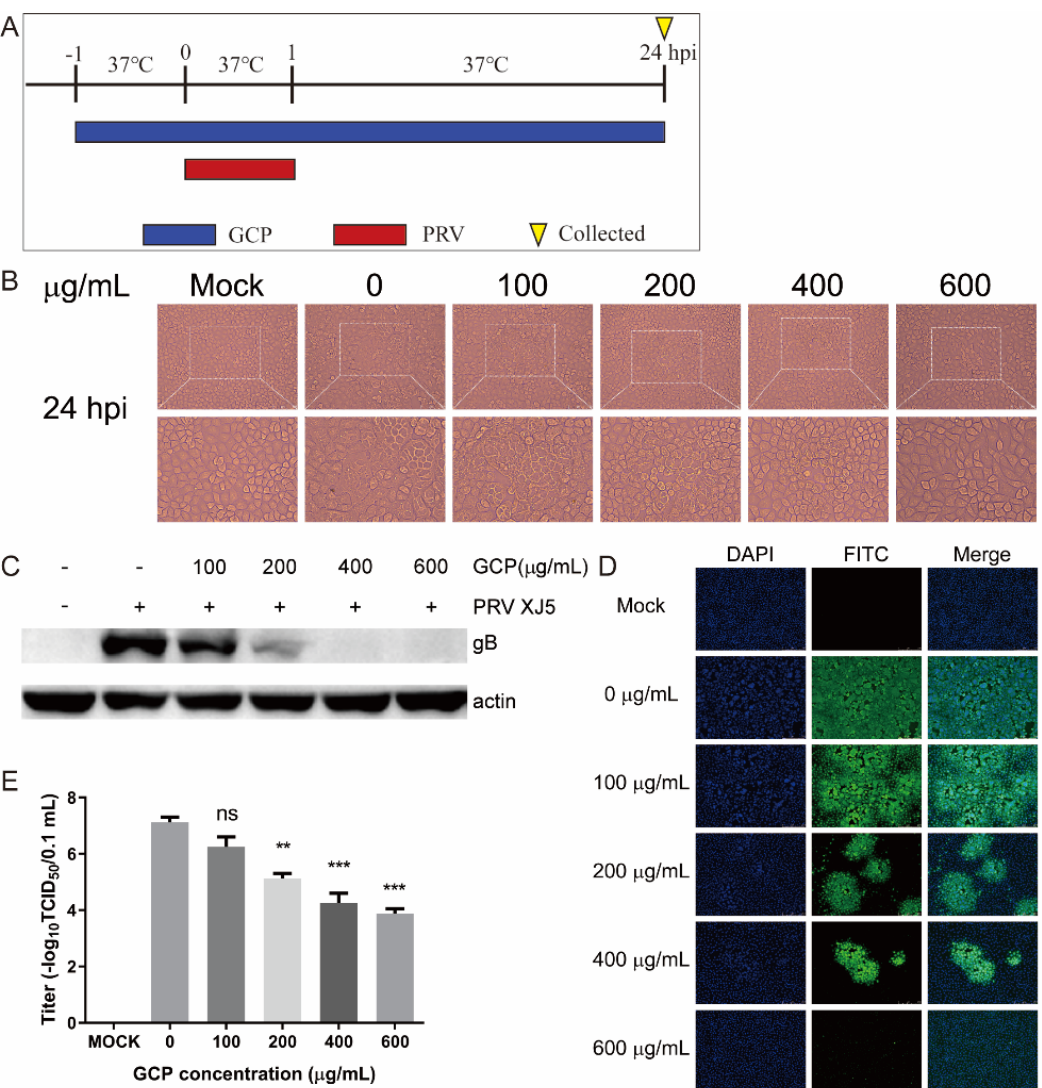
Figure 2. GCP inhibited PRV infection. ( A ) PK-15 cells were treated with GCP for 1 h and then infected with PRV XJ5 (MOI = 0.1) for 1 h. Cells were washed thrice with PBS and then incubated with GCP for another 24 h. ( B ) CPE observed by a microscope. ( C ) Expression levels of gB protein and actin analyzed by Western blot. ( D ) The internalized virus was detected by immunofluorescence assay. ( E ) The viral titer in supernatants was quantified by TCID 50 . All results were obtained from three independent experiments and were presented in means ± SD (ns, not significant; ** p < 0.01; *** p < 0.001).